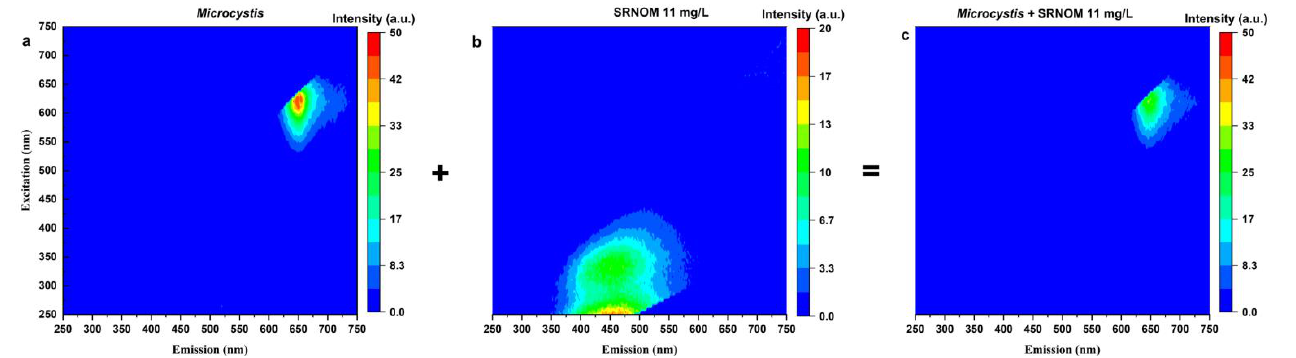
Figure 2. Excitation-emission matrix for ( a ) 100,000 cells/L Microcystis aeruginosa CPCC 300 suspension in ultrapure water, ( b ) 11 mg/L DOC of SRNOM, ( c ) 11 mg/L DOC of SRNOM added to 100,000 cells/L Microcystis aeruginosa CPCC 300 suspension in ultrapure water. Note the Microcystis aeruginosa intensity is twice as high as that of SRNOM.